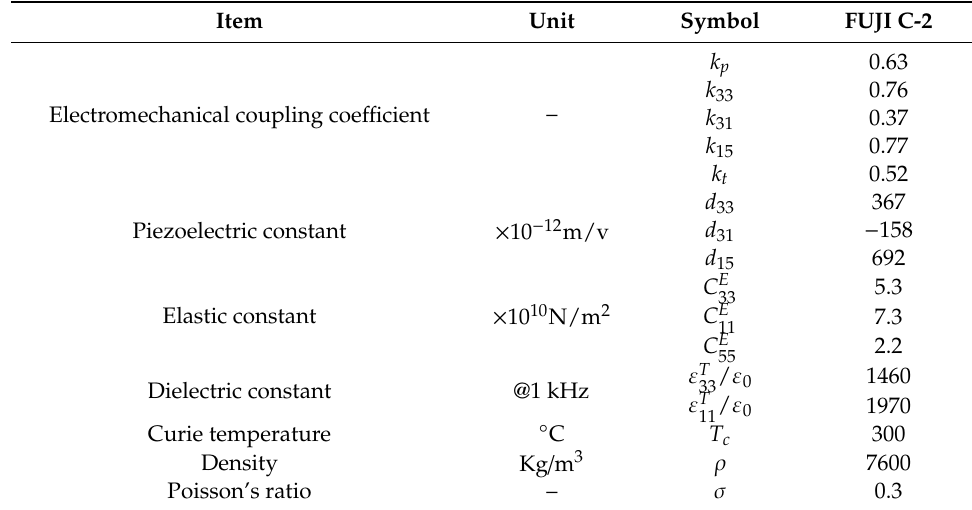
Table A2. Material constants of APC-855 piezoceramic provided from Fuji Ceramics Corporation. Item